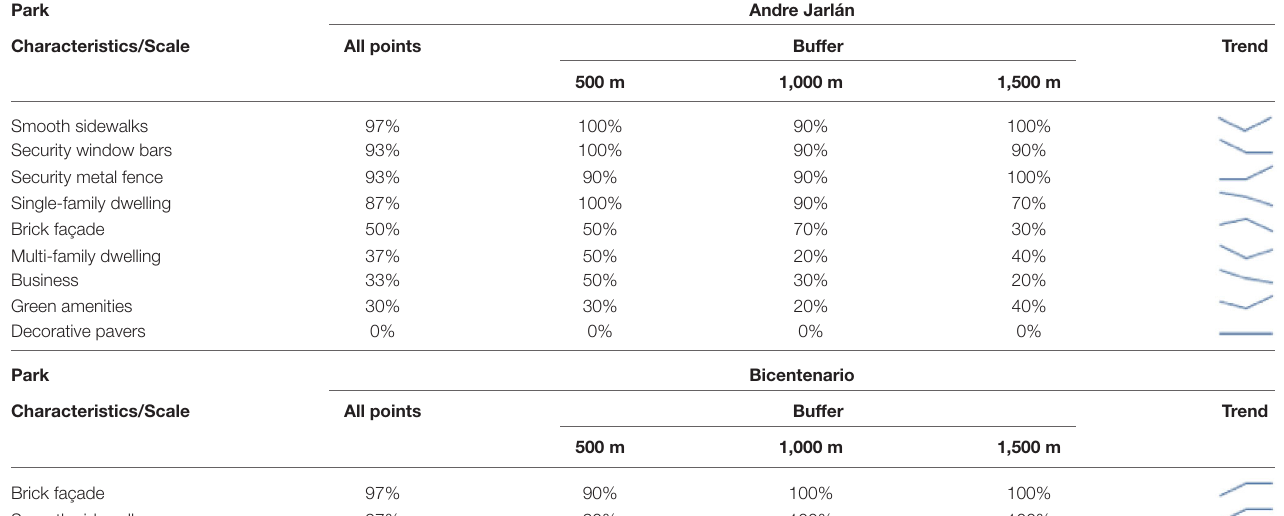
TABLE 4 | Prevalence of selected characteristics surrounding each park, in total and by 500, 1,000, and 1,500m buffers. Park Andre